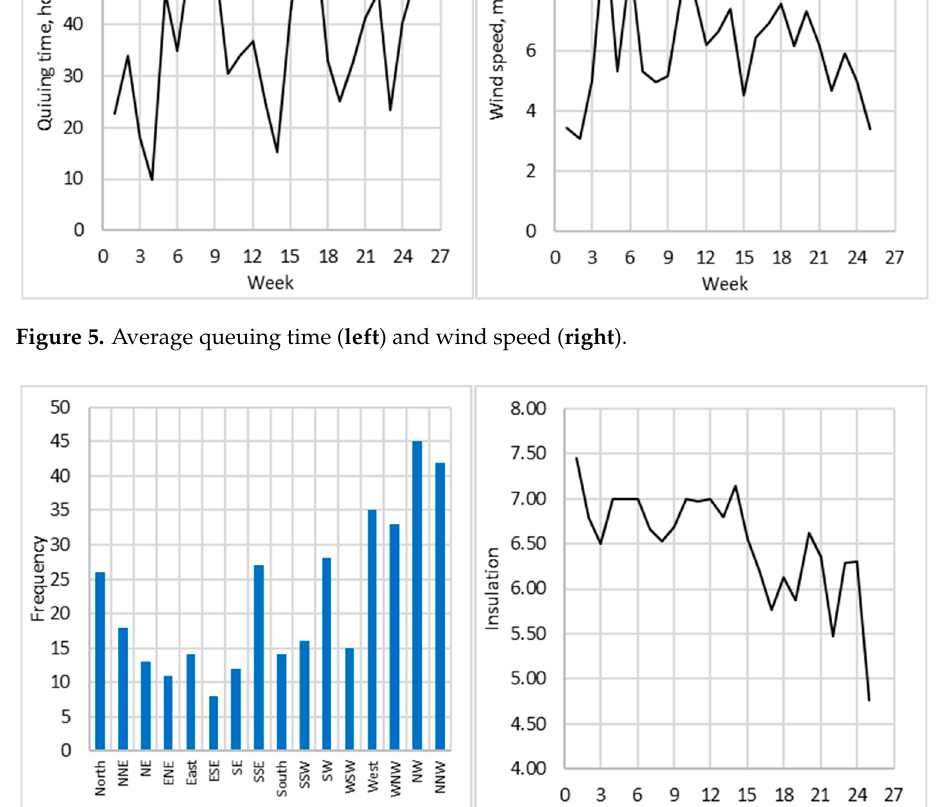
Figure 6. Average wind direction ( left ) and weather stability ( right ).